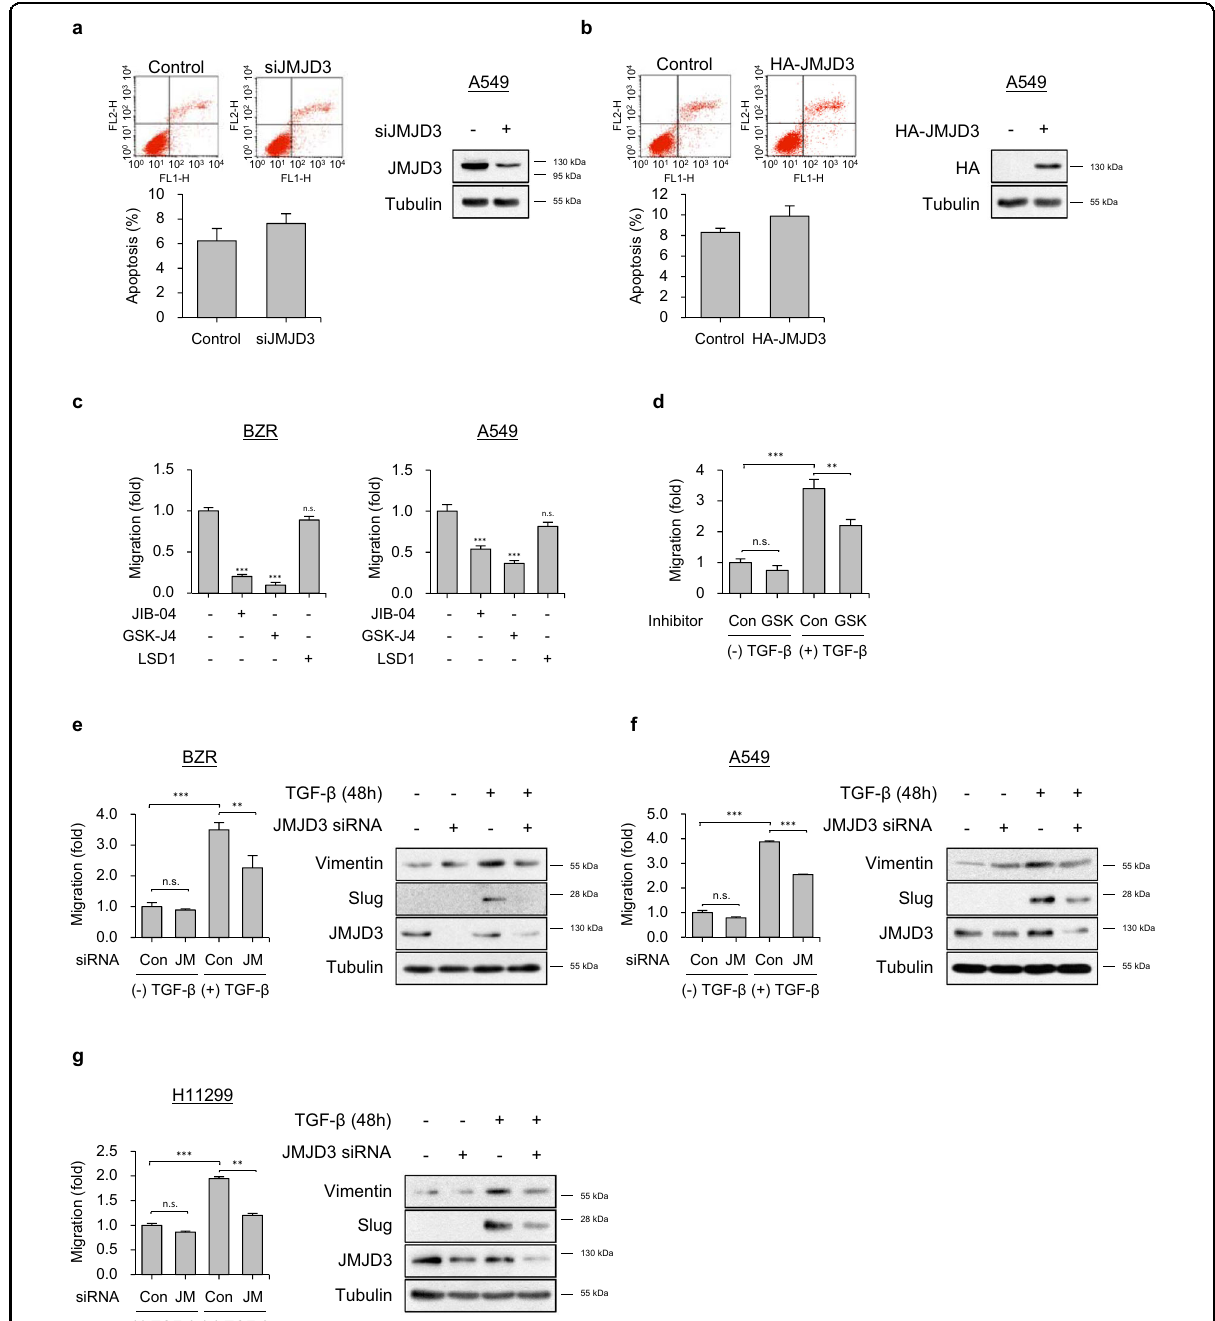
Fig. 2 JMJD3 promotes TGF- β 1-mediated migration and EMT in Ras-activated lung cancer cells. a , b Flow cytometry analysis for apoptosis in A549 cells transfected with a JMJD3 siRNA or b HA-JMJD3 expression vector. The cells were stained with Annexin V and PI, followed by analysis using fl ow cytometry. The percentage of apoptotic cells is shown in the bar graph. Whole-cell lysates were blotted with the indicated antibodies. c Transwell migration assay on BZR (left panel) or A549 (right panel) cells in response to JIB-04 (10 μ M), GSK-J4 (10 μ M), or LSD1 (10 μ M). Columns, mean of two independent experiments performed in triplicate; bar , S.D.; *** P < 0.001 versus control, n.s.: nonsigni fi cant. d Transwell migration assay on A549 cells in response to GSK-J4 (10 μ M) in the presence or absence of TGF- β 1 (5 ng/ml). Columns, mean of two independent experiments performed in triplicate; bar , S.D.; ** P < 0.01, *** P < 0.001, n.s.: nonsigni fi cant. e – g Transwell migration assay on e BZR, f A549, or g H1299 cells transfected with JMJD3 siRNA in the presence or absence of TGF- β 1 (5 ng/ml) (left panel). Expression level of vimentin and slug, as assessed by western blot analysis (right panel). Columns, mean of two independent experiments performed in triplicate; bar , S.D.; ** P < 0.01, *** P < 0.001 versus control, n.s.: nonsigni fi